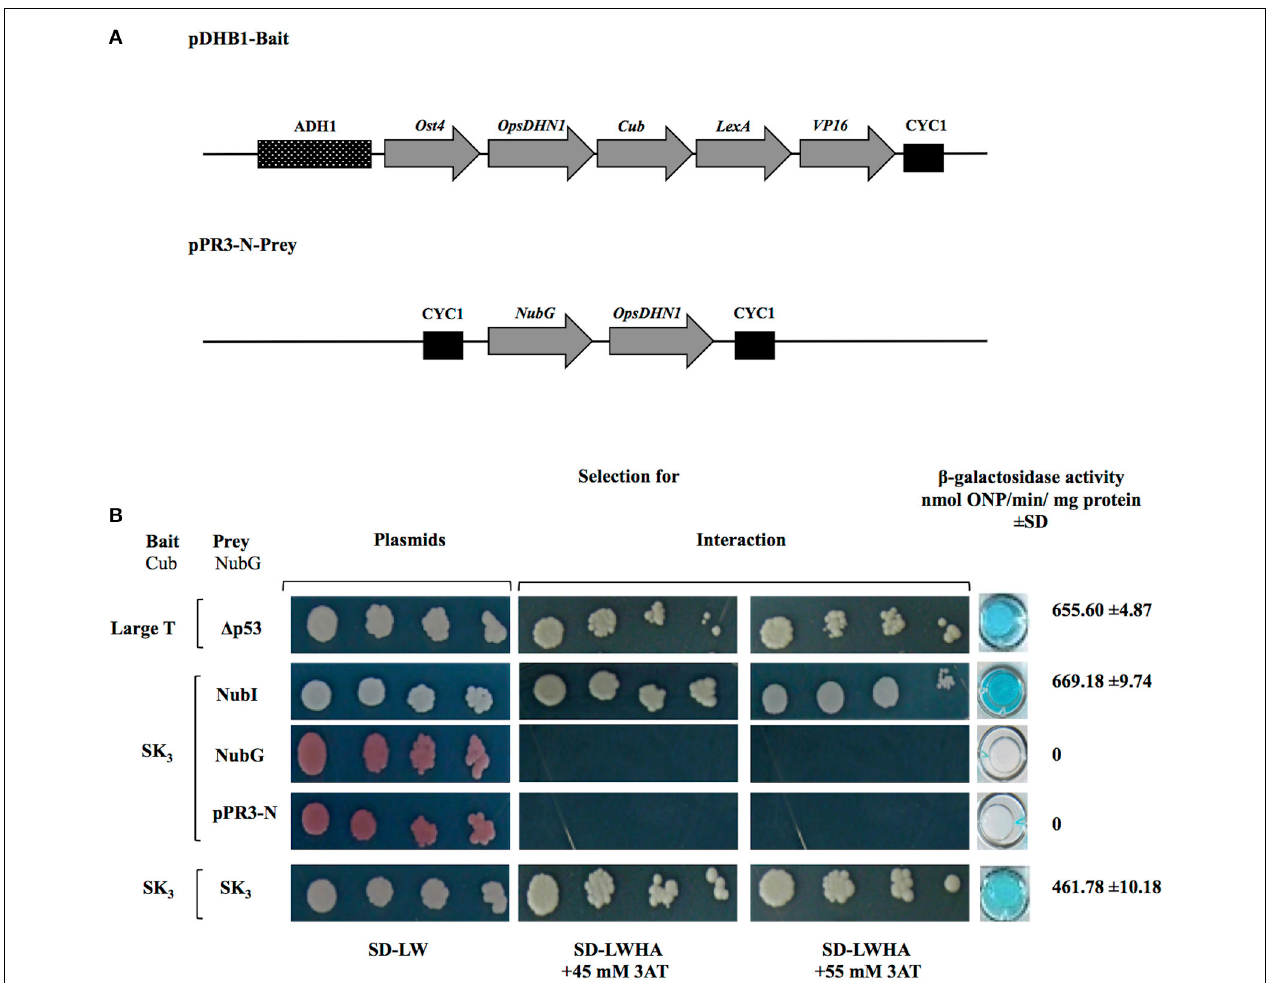
FIGURE 2 | OpsDHN1-OpsDHN1 protein interaction using the split-ubiquitin yeast two-hybrid assay. (A) Schematic representation of OpsDHN1 bait and prey constructs. In the pDHB1 construct, the OpsDHN1 gene was fused at its N-terminal to the Ost4 membrane protein, and its C-terminal to the ubiquitin C-terminal moiety. LexA-VP16, the artificial transcription factor, is fused at the C-terminal end of ubiquitin. This construct is under control of the ADH1 promoter region and CYC1 terminator region. In the pPR3-N-prey construct, the ubiquitin N-terminal was fused to the OpsDHN1 gene. This construct is under control of CYC1 promoter region and